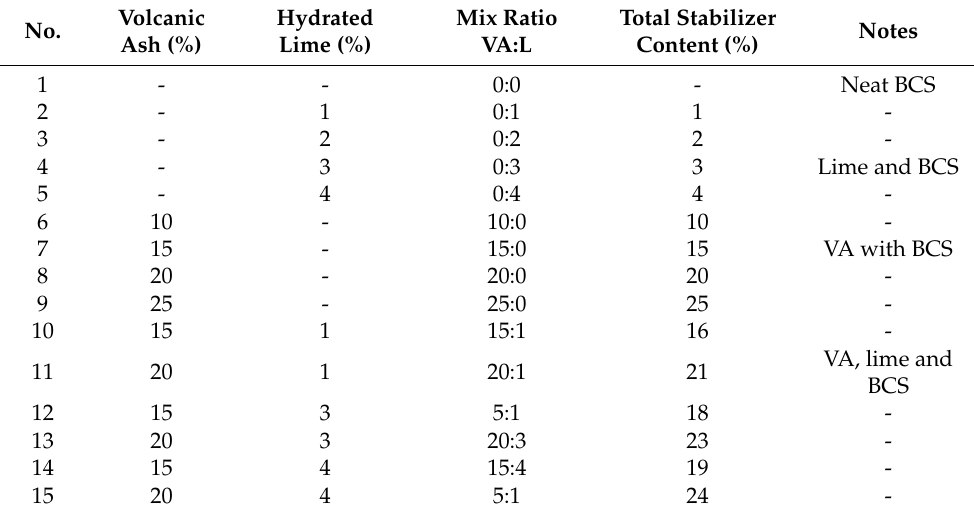
Table 3. The design scheme for BCS